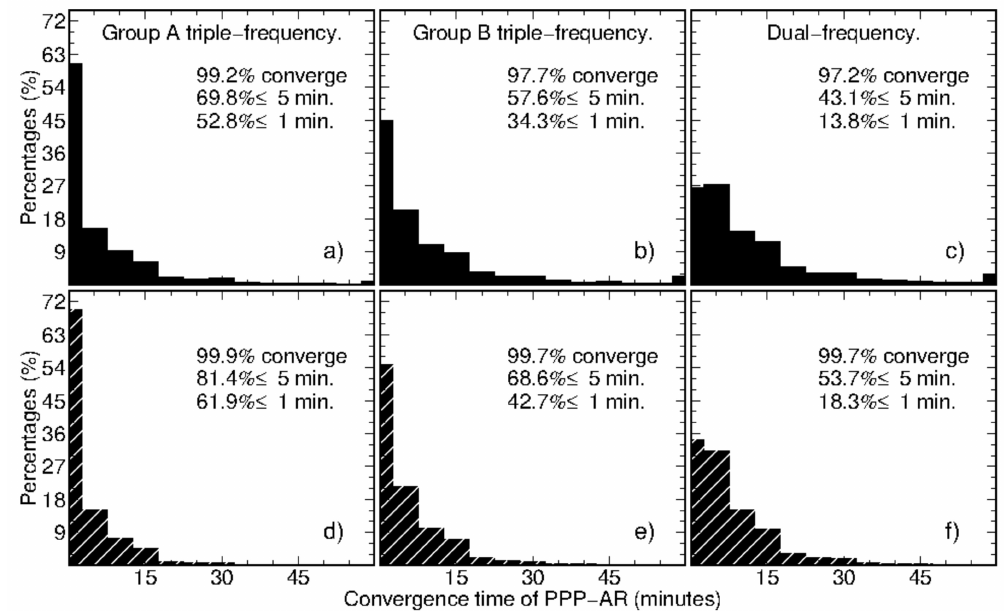
Figure 4. Distribution of PPP-AR convergence times with respect to dual satellite clock cases. Panels ( a – c ) display the results of Group A triple-frequency, Group B triple-frequency, and dual-frequency PPP-AR, respectively, while ( d – f ) are the corresponding distributions calculated with the solutions that observed more than 10 satellites. The percentages of the solutions converging successfully in 1 h, 5 min, and 1 min are also given in the right-top corner of each panel.